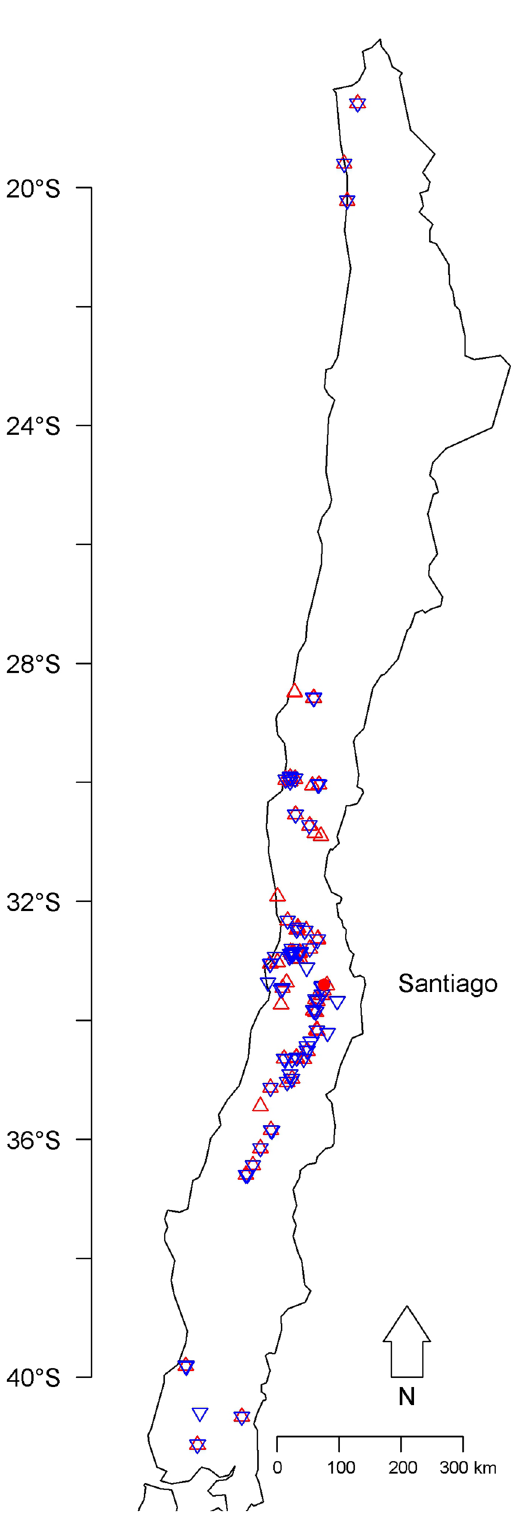
Figure 4. Sites sampled for Diaspididae (red upward-pointing triangle, n = 116) and for Coccidae (blue downward- pointing triangle, n = 112). Figure created using the software R 44 : library ‘maps’ 56